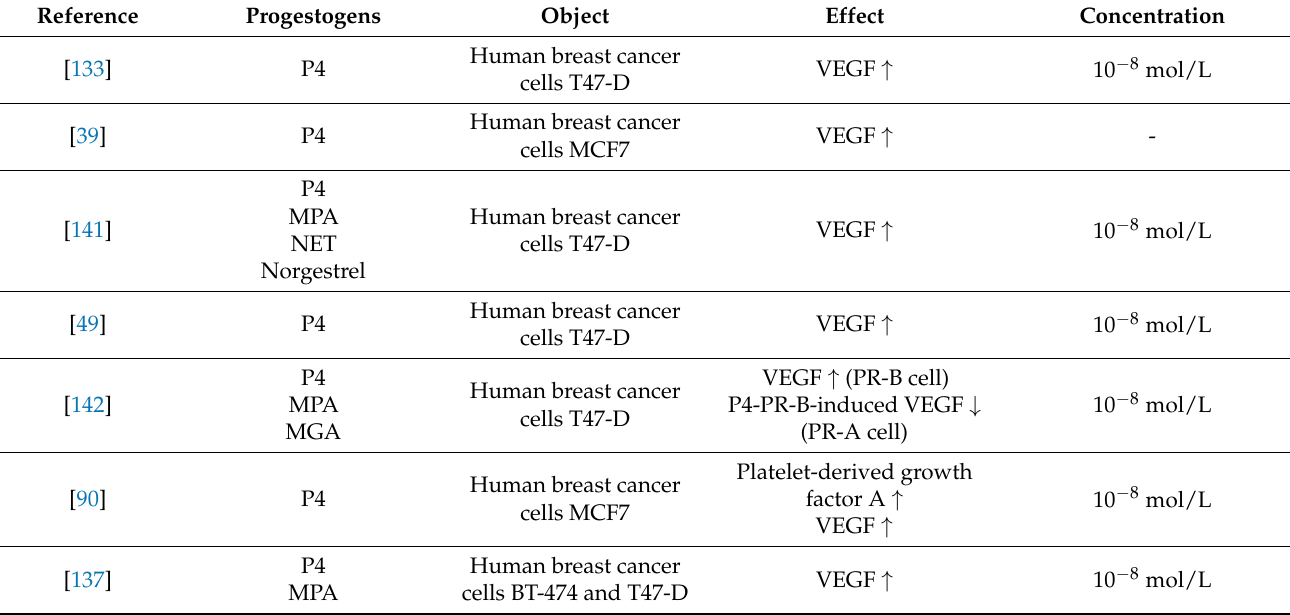
Figure 3. Schematic representation of the main signaling pathways, pertinent angiogenic factors and influencing factors involved in progestogen-mediated neovascularization. Table 1. The influence of progestogens in in vitro studies: ↑ indicates a promoting effect; ↓ indicates an inhibitory effect. E2: estradiol; LNG: levonorgestrel; MPA: medroxyprogesterone acetate; NET: norethindrone; P4: progesterone; PD-ECGF: platelet-derived endothelial cell growth factor; PR: progesterone receptor; tPA: tissue plasminogen activator; VEGF: vascular endothelial growth factor; VEGFR: vascular endothelial growth factor